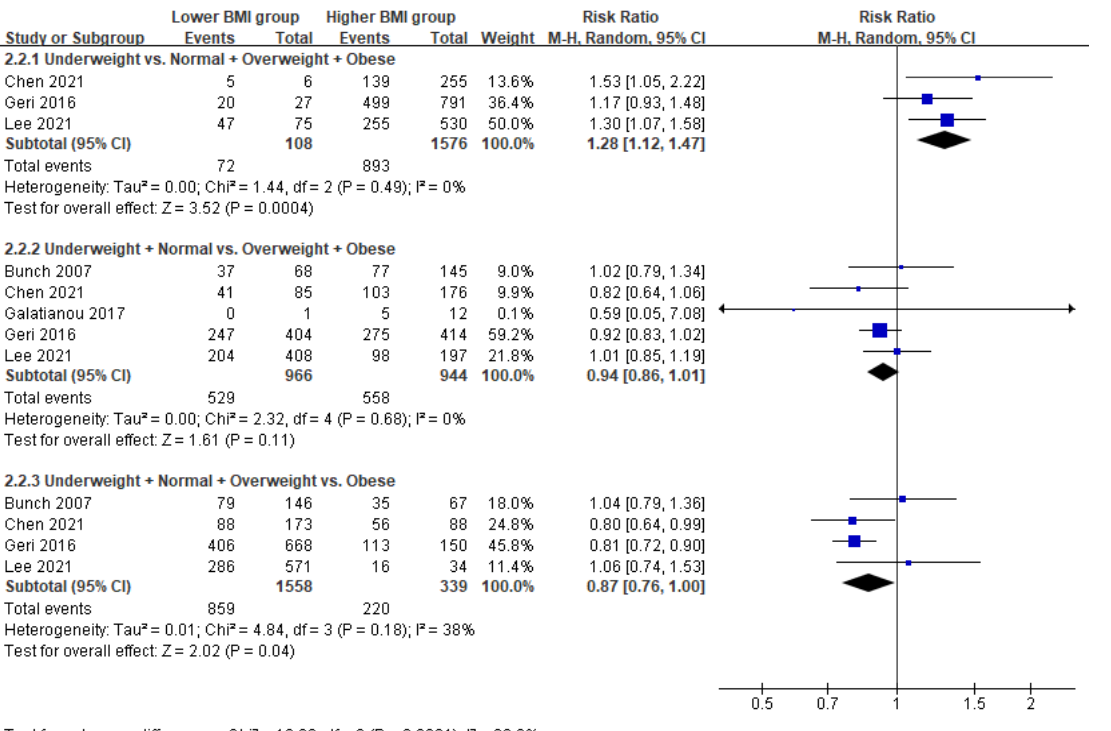
Figure 4. Forest plot of the association between body mass index categories and in-hospital mortality in patients with return of spontaneous circulation after out-of-hospital cardiac arrest.